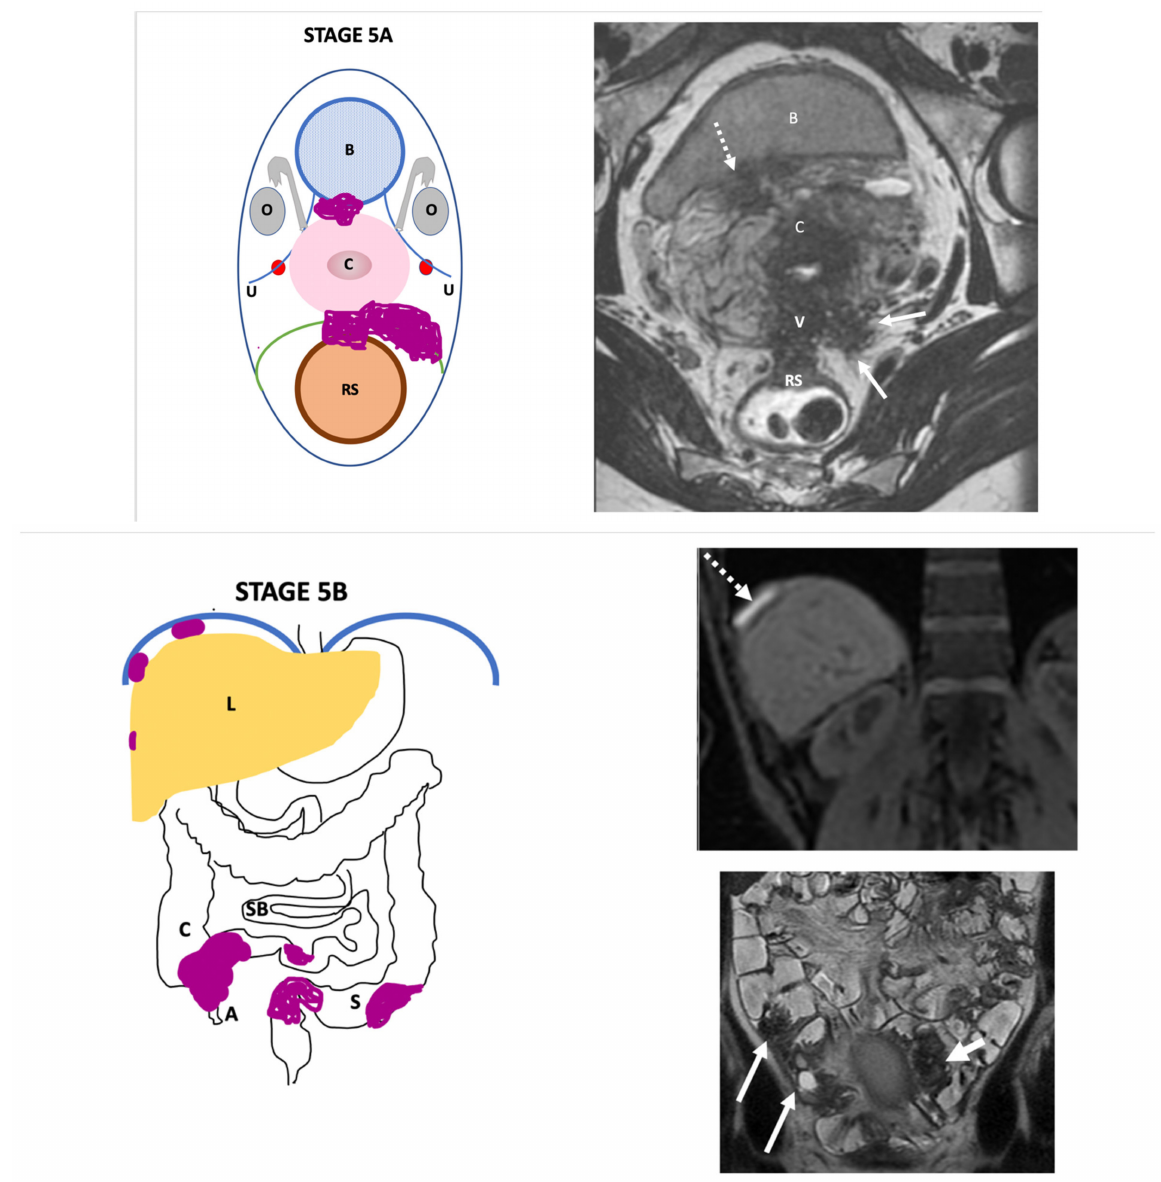
Figure 6. Schematic and example of stage VA Endo-Stage MRI classification showing the presence of more than three deep pelvic endometriotic locations as follows: extensive deep posterior and deep lateral endometriosis displaying low signal intensity on a T2-weighted MRI and multiple tiny high signal intensity foci. This lesion involves the vagina ( V ), rectosigmoid colon ( RS ), left parametrium and sacro-recto-genital fascia (arrows) and bladder (dotted arrow). Schematic and examples of stage VB Endo-Stage MRI classification showing the presence of multiple extrapelvic deep endometriotic locations, some with small high signal intensity foci on a T1-weighted MRI with fat saturation. Note the endometriotic implants located on the undersurface of the right diaphragm (11b, dotted arrow) and on the extrapelvic intestinal sites (11c) showing low signal intensity on T2-weighted implants involving the cecum (arrows) and sigmoid colon (short arrow). Note: ( O ): ovary, ( U ): ureter, ( C ): cecum, ( B ): bladder, ( A ): appendix; ( S ): sigmoid colon, ( SB ): small bowel, ( L ):